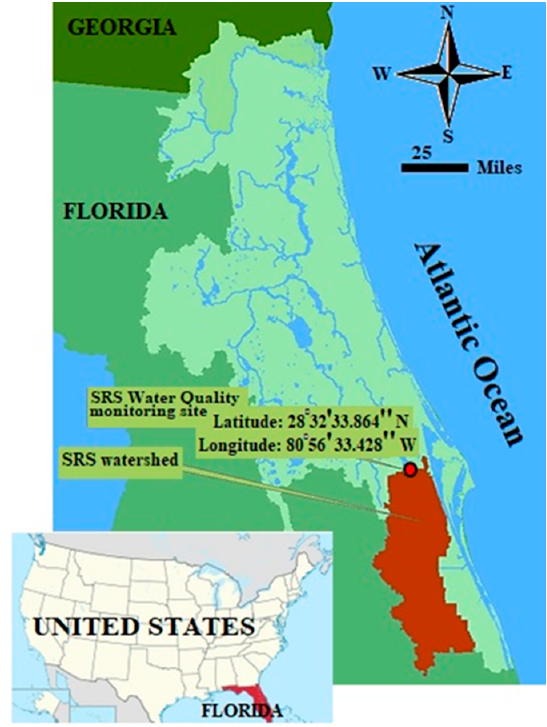
Figure 5. Location of the study area and the water quality monitoring station.